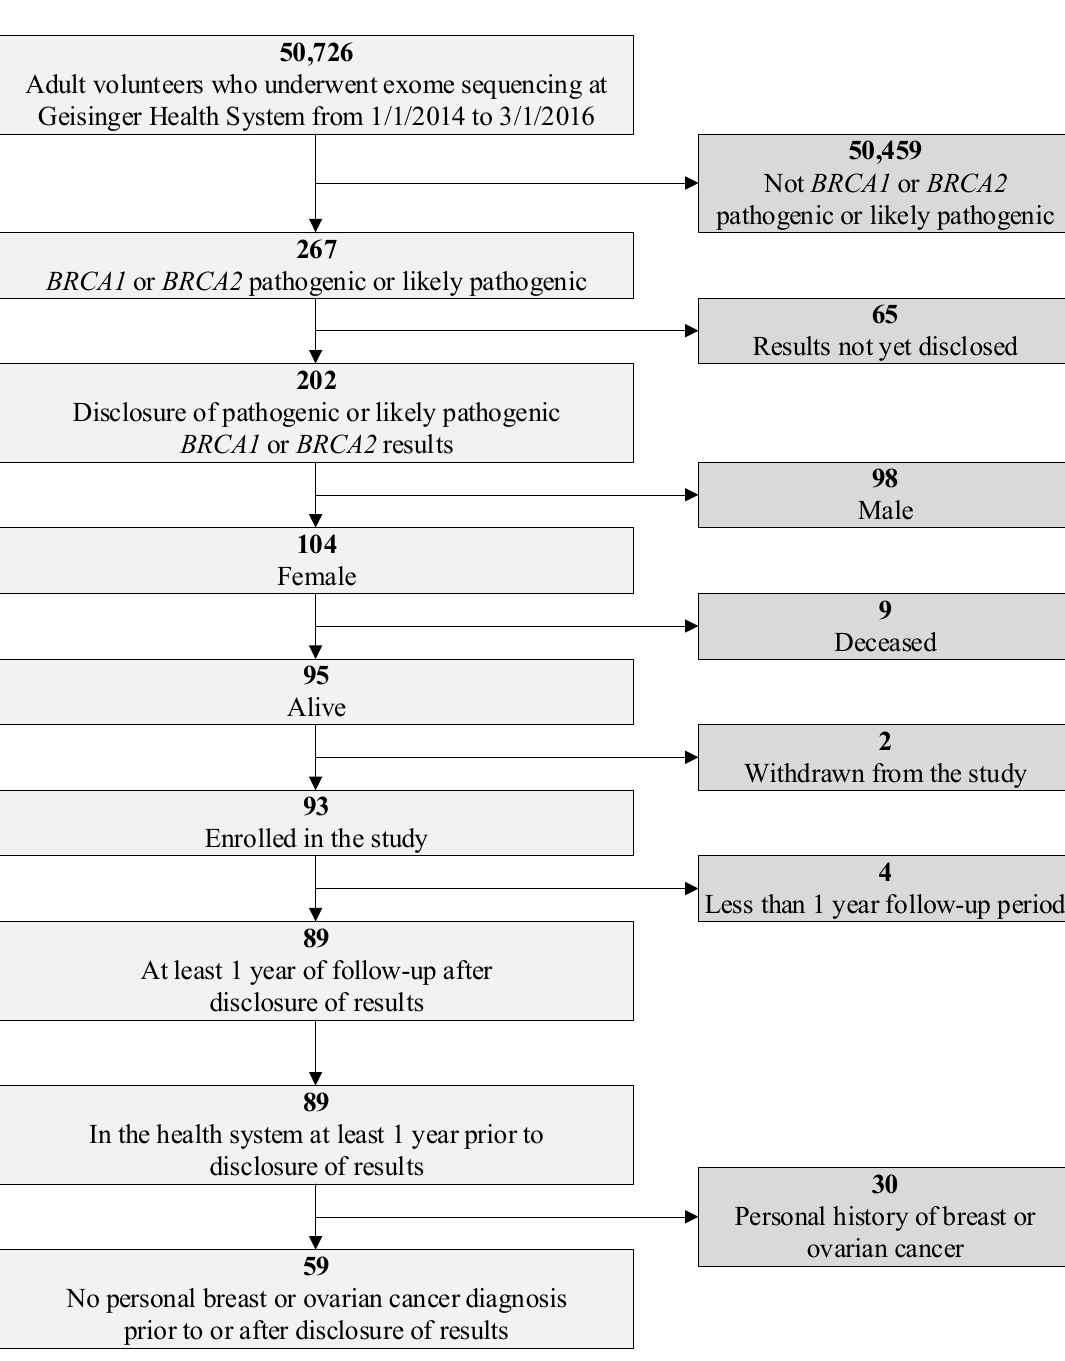
Figure 1. Study population.